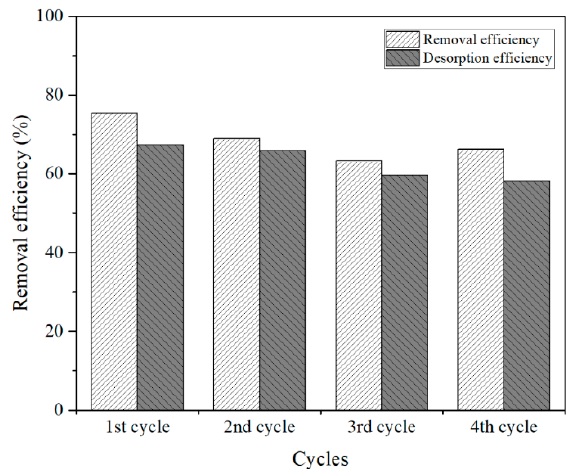
Figure 11. Regeneration studies of adsorption and desorption of As(III).